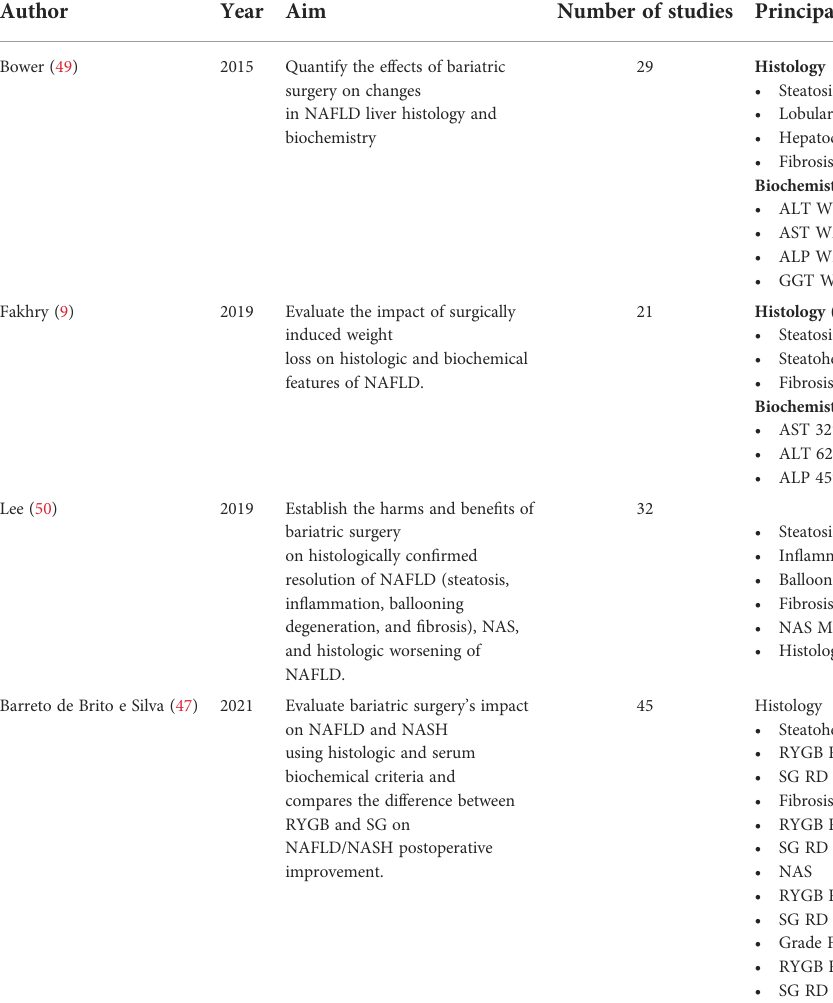
TABLE 1 Results of meta-analysis of bariatric procedures in non-alcoholic fatty liver disease.